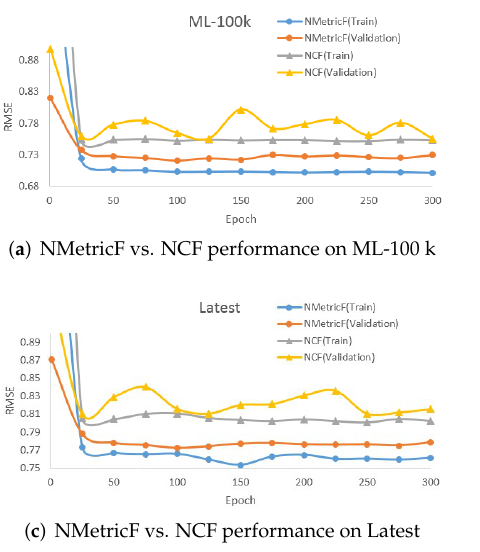
Figure 5. Performance comparison of NMetricF and NCF with the same complexity. ( a ) NMetricF vs. NCF performance on ML-100 k. ( b ) NMetricF vs. NCF performance on ML-1 M. ( c ) NMetricF vs. NCF performance on Latest. ( d ) NMetricF vs. NCF performance on ML-1